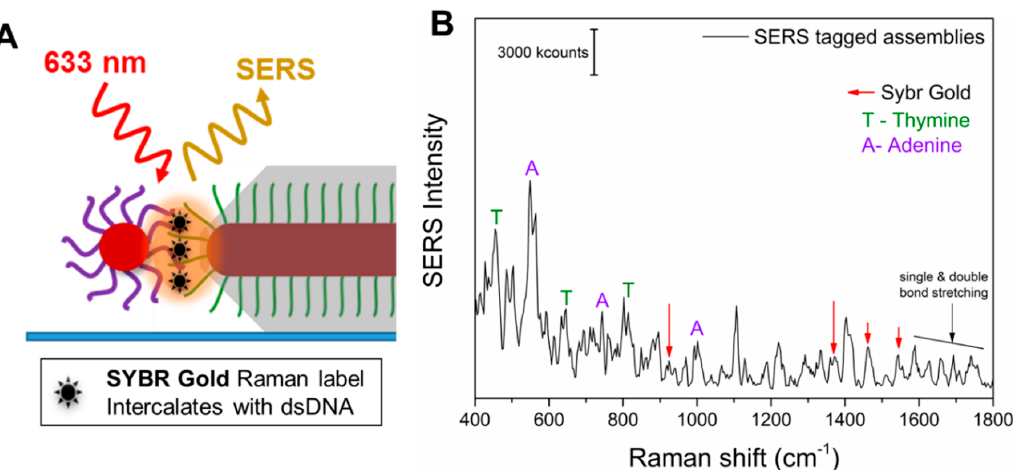
Figure 6. ( A ) Magnified depiction of a SYBR-gold-tagged anisotropic directional nanoassembly spin- coated onto a glass substrate. The SYBR gold intercalates within the dsDNA. The plasmonic hot-spot is depicted in orange. ( B ) Representative SERS spectrum from a SYBR-gold-tagged directional nanoassembly. The signature peaks of adenine (A), thymine (T), and SYBR gold are indicated.